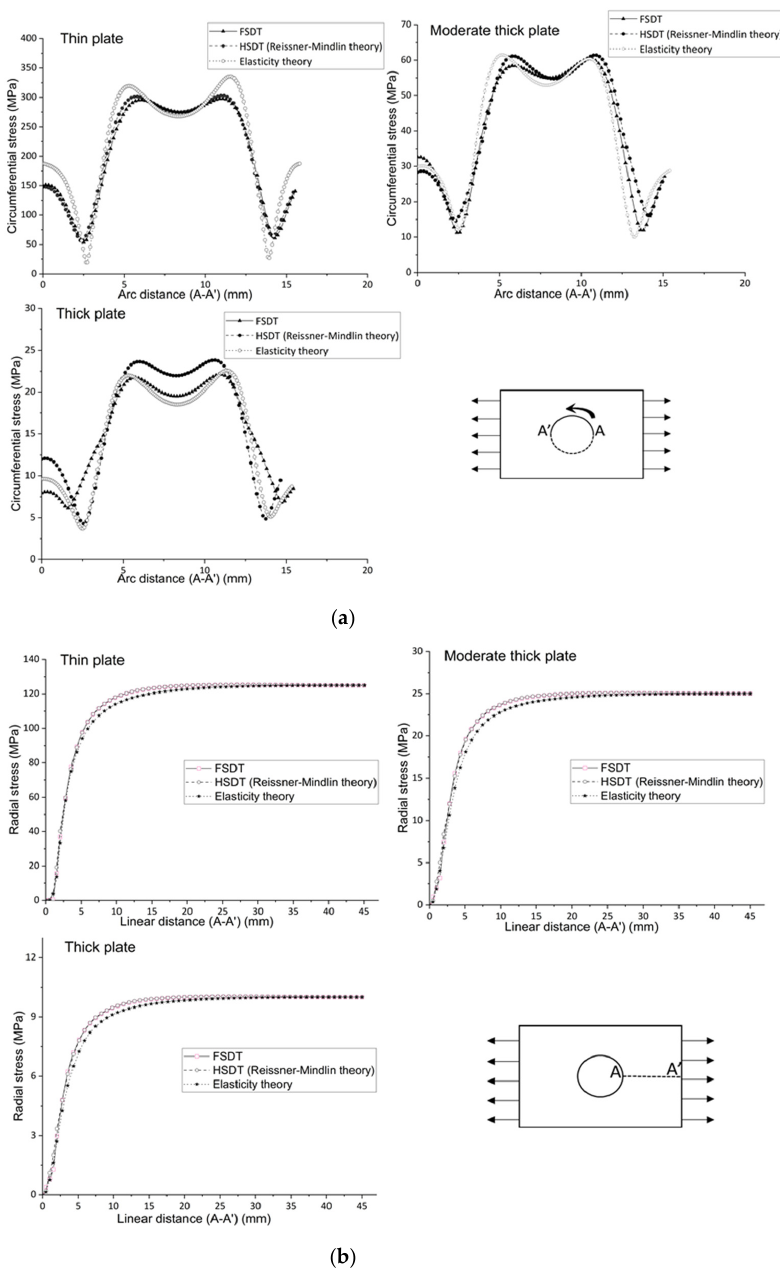
Figure 10. Stress variation around the hole radius for the braided polymer plate under uniaxial tension ( a ) Circumferential and ( b ) Radial. the hole radius in the braided plate due to its directional material behavior. The radial and